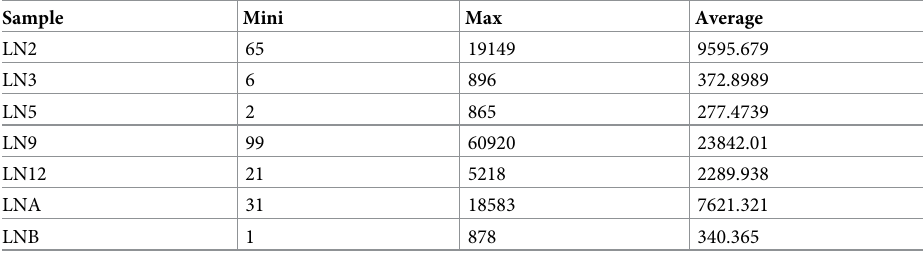
Table 1. The coverage summary values (read